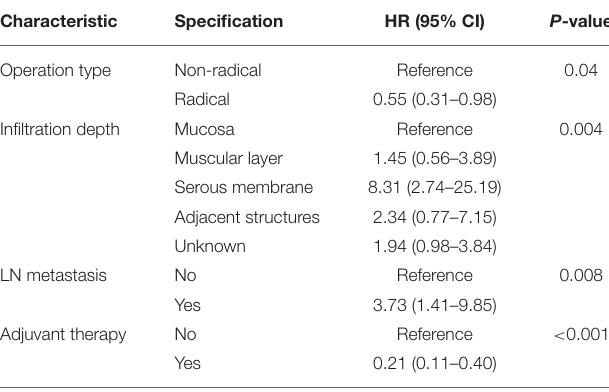
TABLE 3 | Results of multivariate analyses of recurrence-free survival